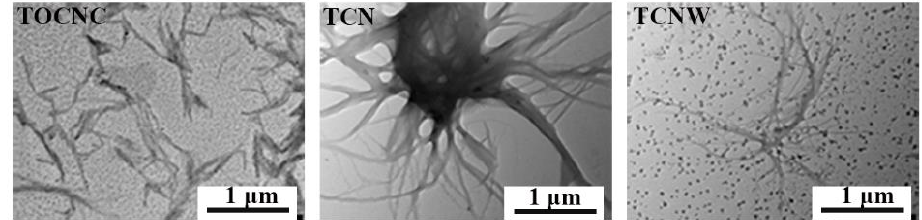
Figure 1. TEM images of TOCNC, TCN and TCNW particles.